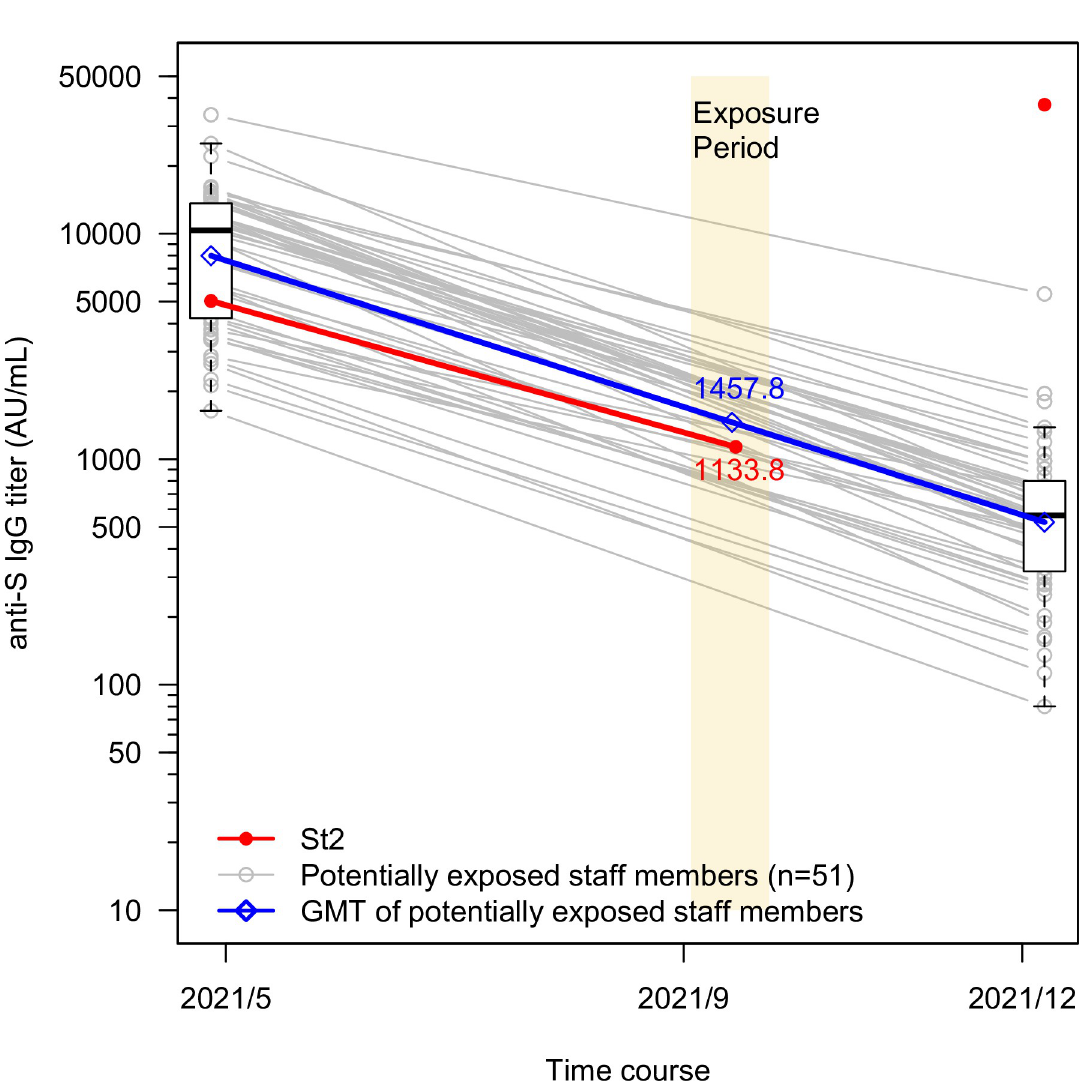
Fig 2. Reduction of anti-S IgG titers after SARS-CoV-2 vaccination in potentially exposed staff members and staff 2. Exposure period, defined as from two days before the onset of the first person to the end of the isolation period of the last person, is highlighted in yellow. In the 51 potentially exposed staff members, the grey circles and lines show anti-S IgG titers and their connection at the measurement points of May and December of 2021 for each. The blue circles and bars indicate the geometric mean titer (GMT) and 95% confidence interval (CI) of the titers at the two points, and the blue line shows the connection of their GMTs. The blue diamond indicates the GMT of estimated anti-S IgG titers calculated on the median day of the exposure period. The red circles and line show the two measured titers and their connection for Staff 2 (St2) with breakthrough